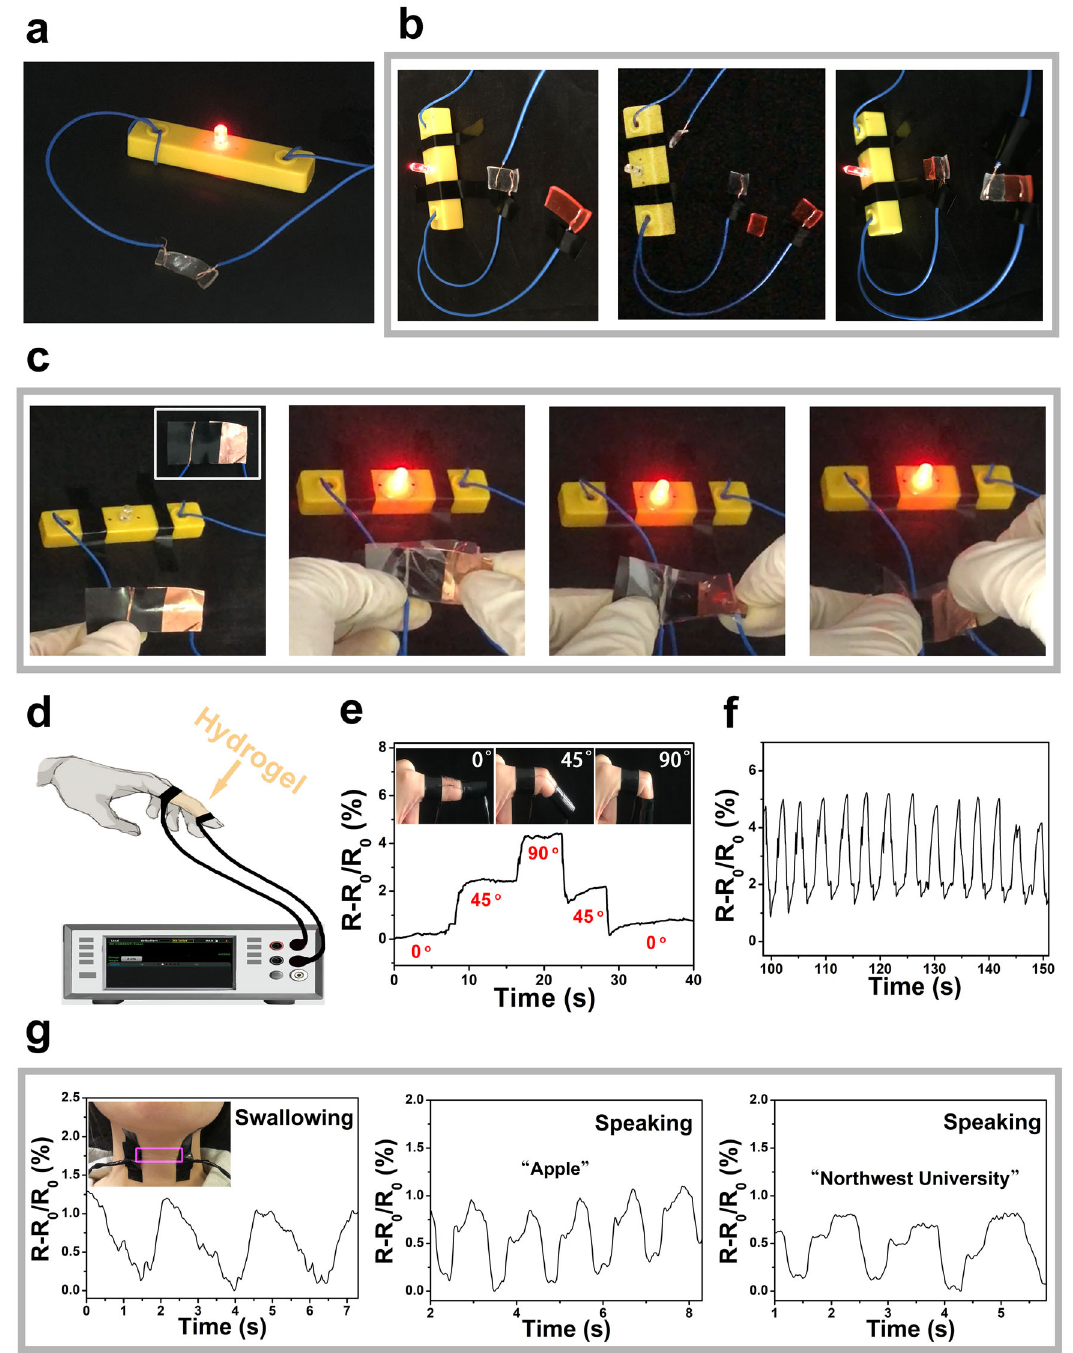
Fig. 4 Electrical properties of PPG hydrogel. a Digital photo of PPG hydrogel in a circuit with LED light. b , c Digital photos of self-healing and self-adaptive property of PPG hydrogel in a circuit. (Details of substrate inserted in c ) d Schematic illustration for fi nger sensing. e , f Relative resistance changes of the PPG hydrogel upon bending fi nger at different angles and bending fi nger several times in a row. g Relative resistance changes of the PPG hydrogel upon swallowing and speaking. (Digital photos of PPG hydrogel as sensor attached on fi nger and throat inserted in e and g